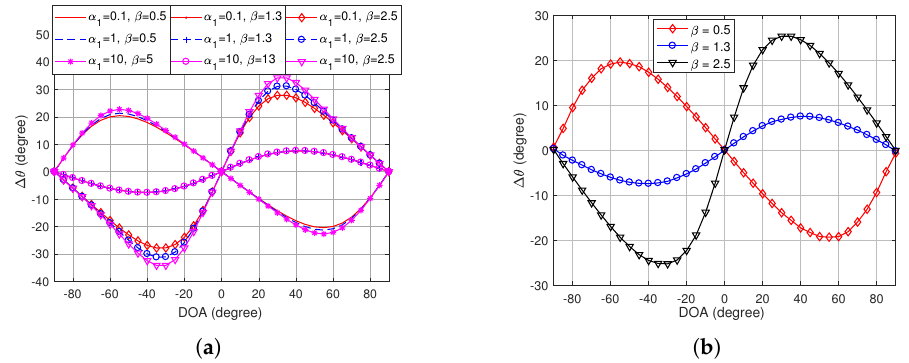
Figure 3. The DOA estimation error varies as a function of DOA. For simplicity, α 1 ( θ ) and β ( θ ) are assumed to be constant. ( a ) directly calculated by Equation (14) for different combinations of β ( θ ) and α 1 ( θ ) ; ( b ) achieved by simulation for different β ( θ ) but α 1 ( θ ) being equal to